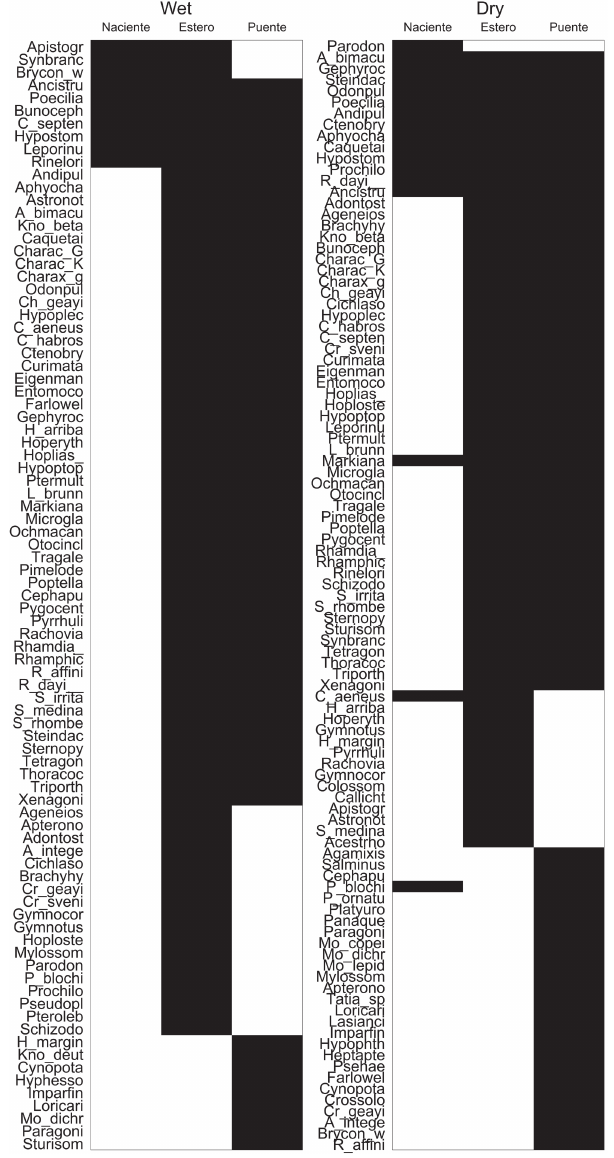
sites during dry and wet seasons.